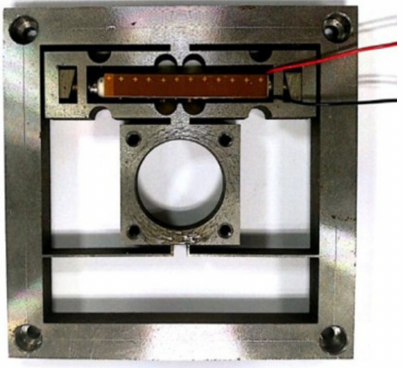
Figure 15. The prototype of the piezoelectric